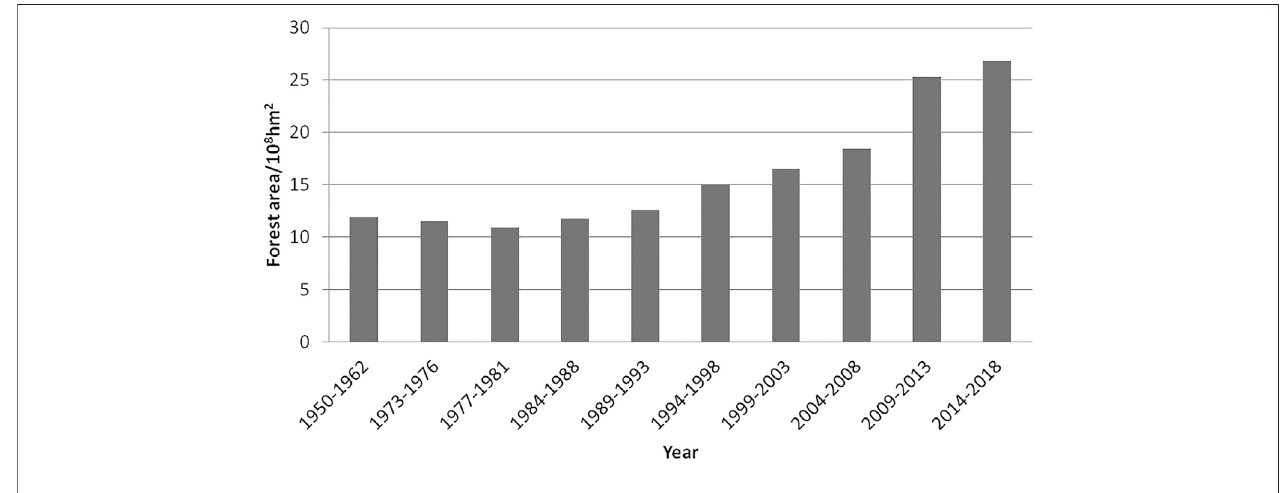
FIGURE 2 | Forest area changes in Northwest China.